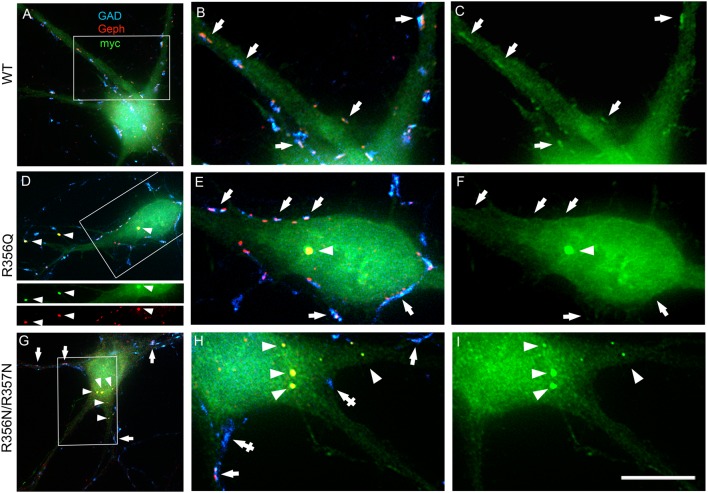
Collybistin phosphoinositide binding mutants R356Q and R356N/R357N alter gephyrin cluster number and size in cultured hippocampal neurones. Triple-label immunofluorescence of transfected hippocampal neurons with mouse anti-myc (green), rabbit anti-gephyrin (red) and sheep anti-GAD (blue). (A–C) Transfection with myc-CB3SH3- (wild-type, WT). (D–F) Transfection with myc-CB3SH3-R356Q (R356Q). (G–I) Transfection with myc-CB3SH3-R356N/R357N (R356N/R357N). The two panels on the right side of each row correspond to the boxed areas in (A,D,G), respectively. Arrows point to GABAergic synapses. Arrowheads point to aggregates of gephyrin that form in transfections with collybistin R356Q or R356N/R357N. Note that there is colocalization of mutant collybistin and gephyrin in these aggregates. Wild-type collybistin does not induce the formation of aggregates but accumulates at GABAergic synapses and colocalizes with gephyrin (arrows, panel C). The R356Q and the R356N/R357N mutants do not accumulate at synapses (arrows, panels F,I). The R356N/R357N mutant (panels H,I) shows a clear decrease in the overall number of gephyrin clusters, including synaptic gephyrin clusters. In neurons overexpressing the R356N/R357N mutant, GAD positive puncta often make contacts without apposed gephyrin clusters (crossed arrows). Scale bar = 26 μm for (A,D,G) and 10 μm for (B,C,E,F,H,I).